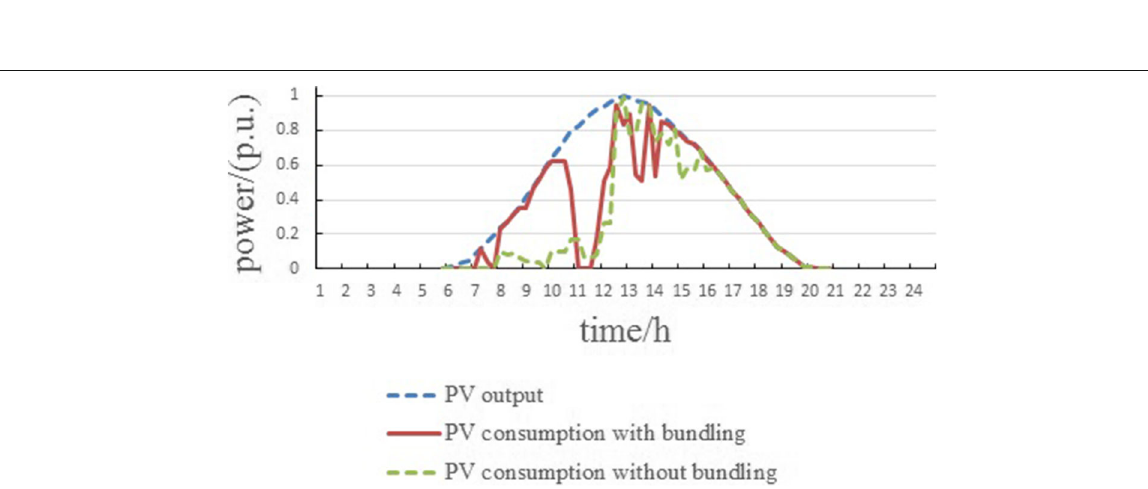
Fig. 7 PV consumption curves with and without PV bundling requirements at a workday in the Summer